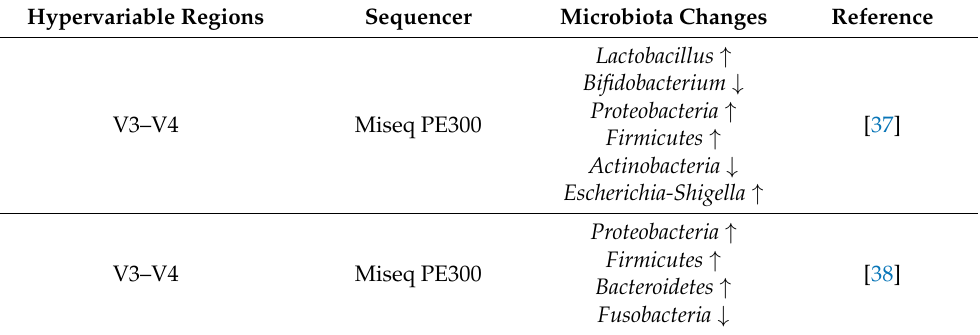
Table 2. Summarization of the studies in which the authors sequenced the 16S rRNA in zebrafish. Hypervariable Regions